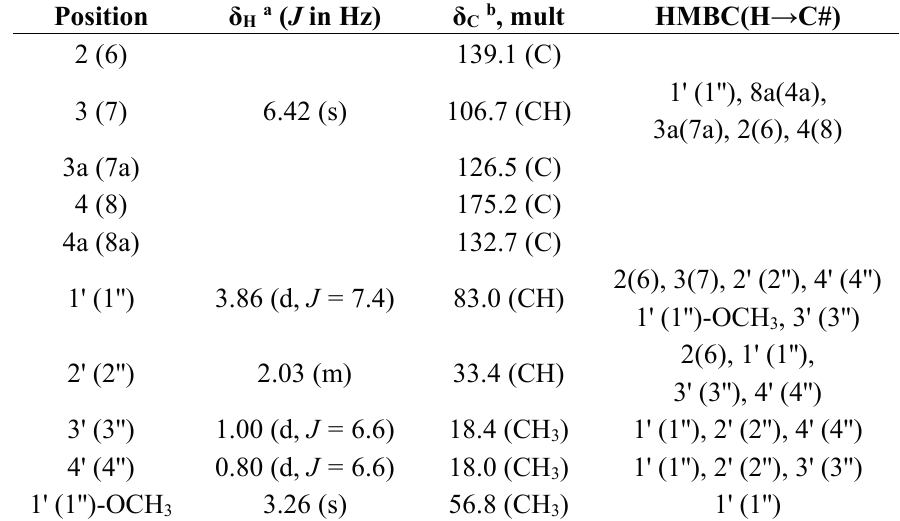
Table 1. NMR Spectroscopic Data for Compound 1 (Terreusinone A) in CD 3 OD- d 6 . Position